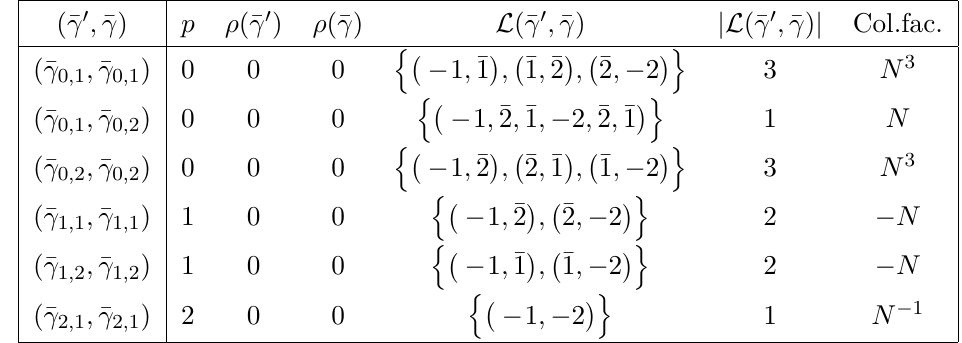
Table 1 . Quantities relevant to eq. (6.11) for ¯ qq → gg , for each non-trivial closed flow. See the text for